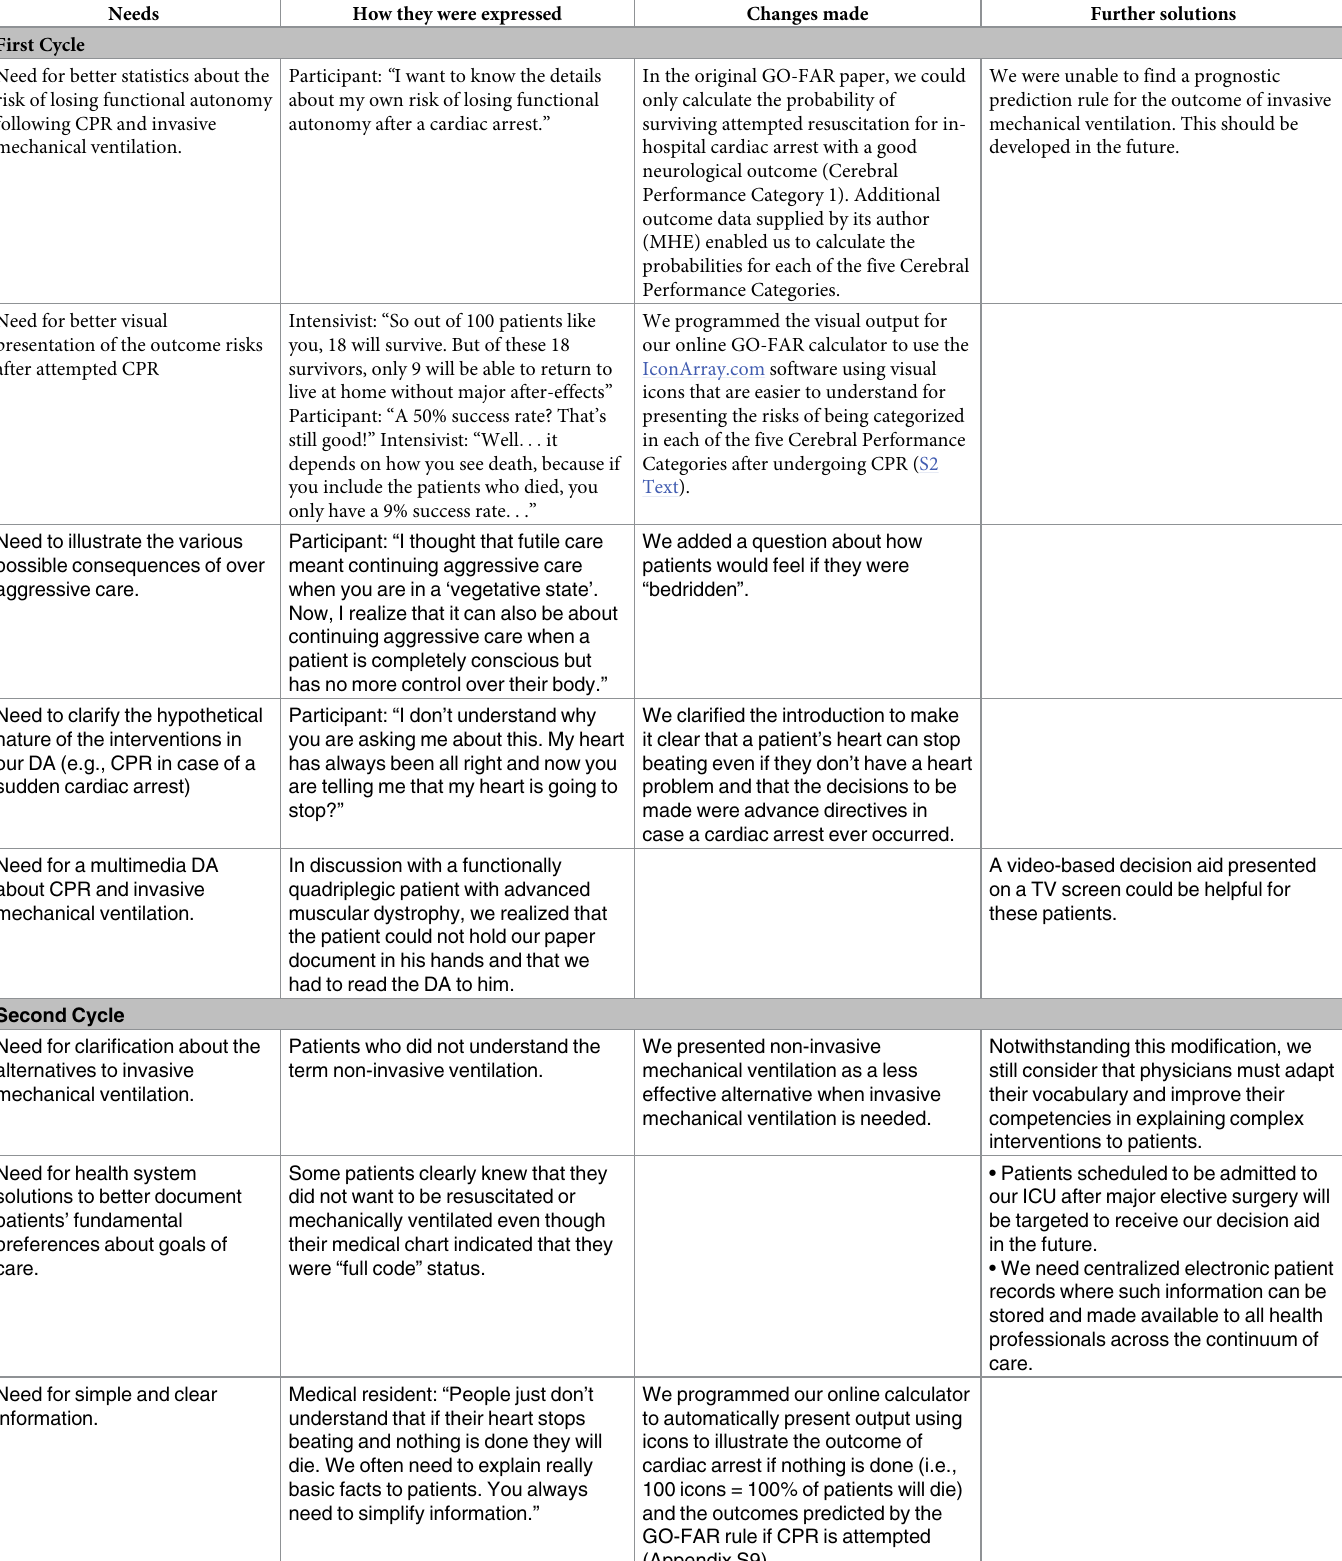
Table 4. Needs identified, needs met through changes to DA made during rapid prototyping, and unmet needs. Needs Changes made Further